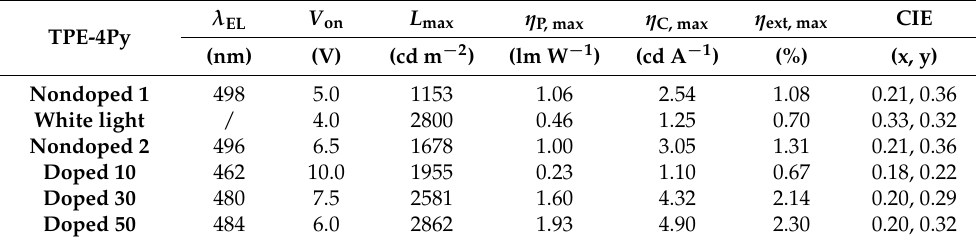
Table 1. The EL performance of TPE-4Py.